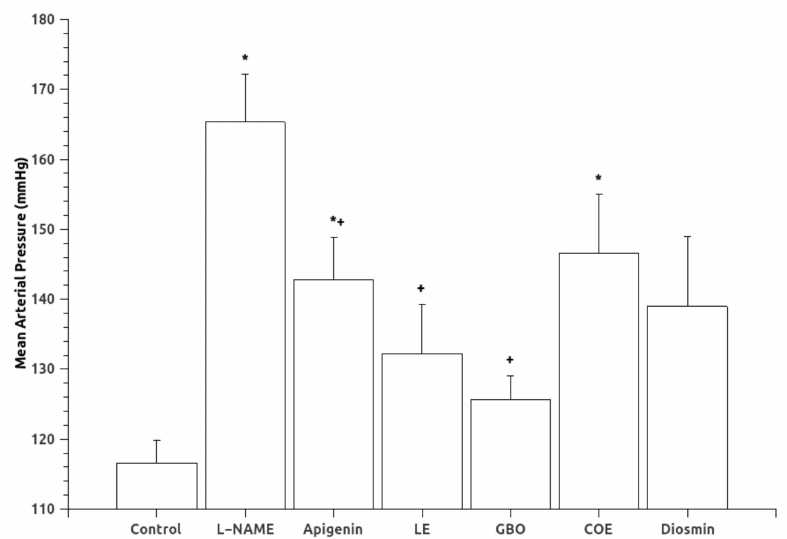
Figure 1. Mean arterial pressure (MAP) in the experimental groups. Abbreviations: L-NAME: ( N (G)-Nitro- L -arginine methyl ester), LE (Lemon extract), GBO (Grapefruit + bitter orange extract), COE (Cocoa extract). Data are mean ± S.E.M. * p < 0.05 vs. Control; + p < 0.05 vs. L-NAME.